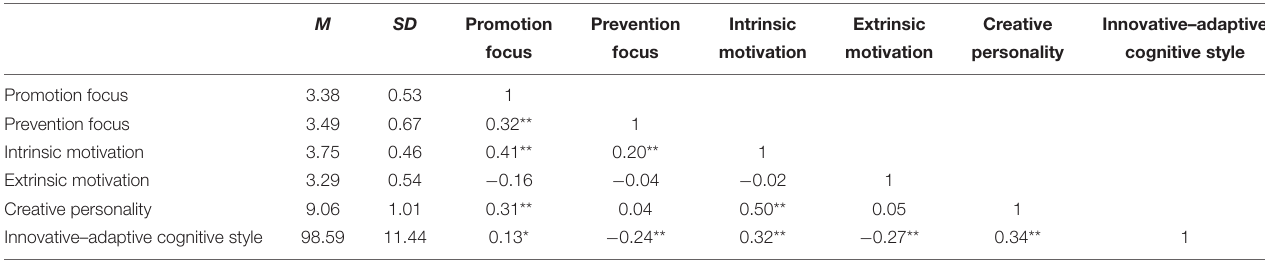
TABLE 1 | Means, standard deviations, and correlations for the observed variables. M